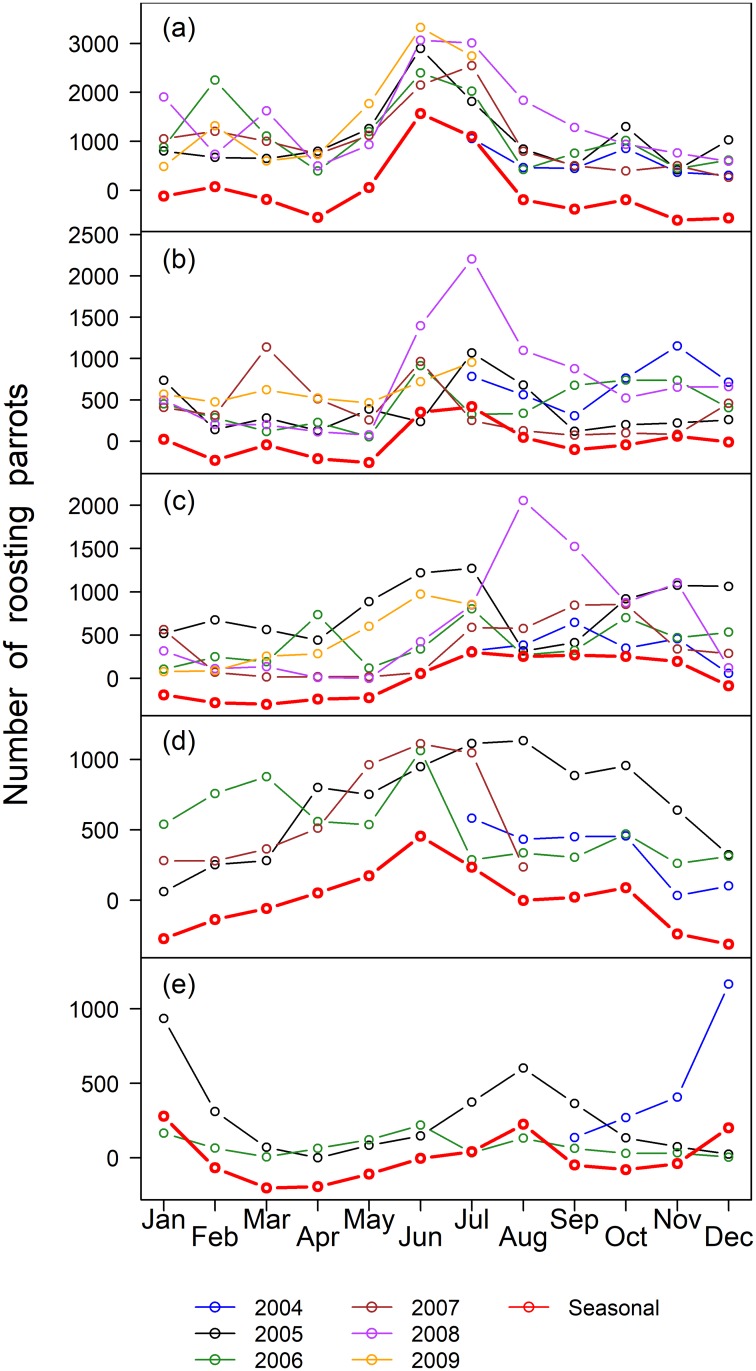
Number of parrots in five roosts in the southern Pantanal of Brazil.Years are coded by colors (see the legend below the plots), and the red line indicate the seasonal component of the counts obtained by STL-decomposition analysis (see Methods). (a) Roost 1, (b) Roost 2, (c) Roost 3, (d) Roost 4, and (e) Roost 5.